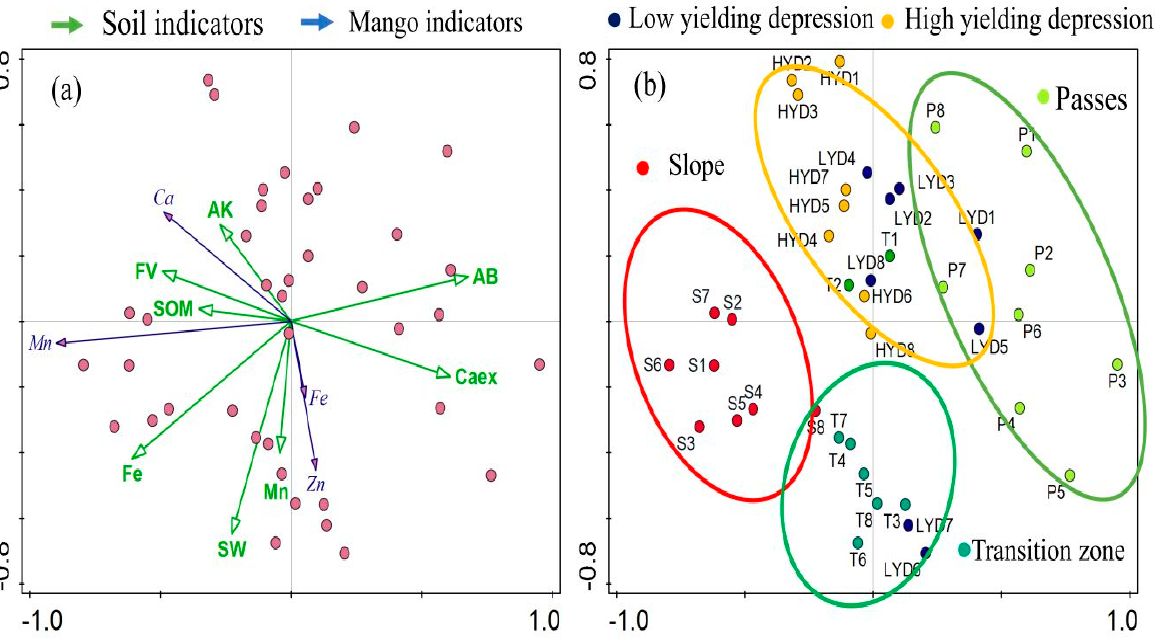
Figure 3. Redundancy analysis (RDA) of soil and mango key factors. ( a ) RDA results of soil key indicators and mango key indicators, ( b ) Clustering of quadrats of different geomorphic parts.